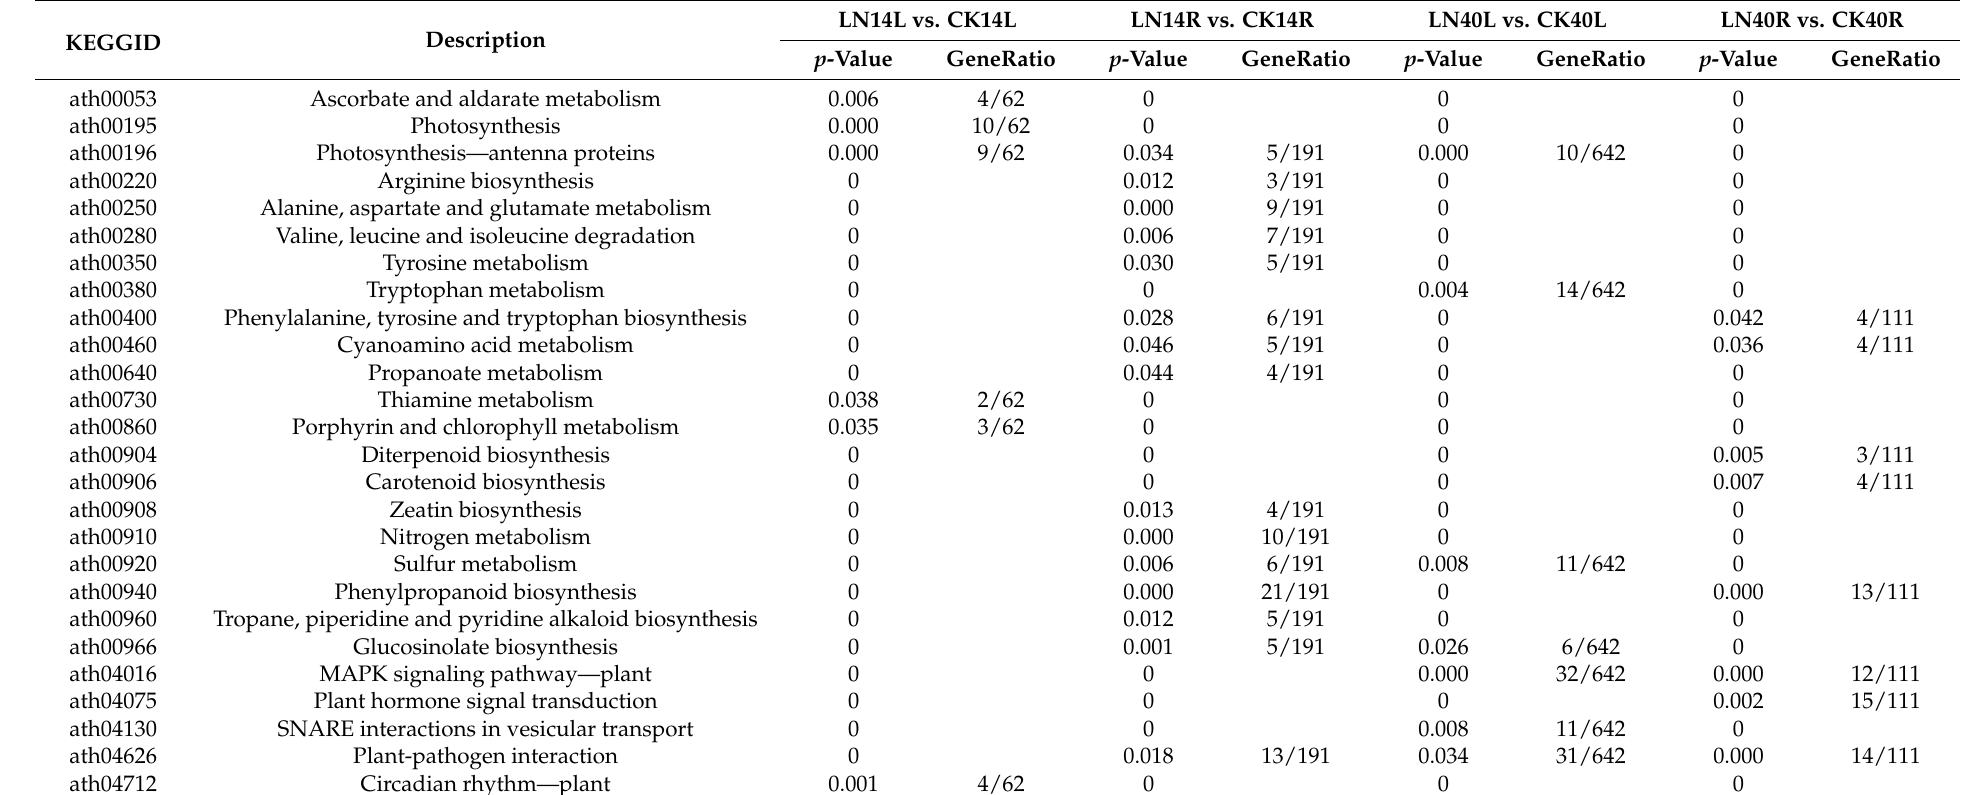
Table 3. Pathway classification of differentially expressed genes in L14 and L40 ( p -value ≤